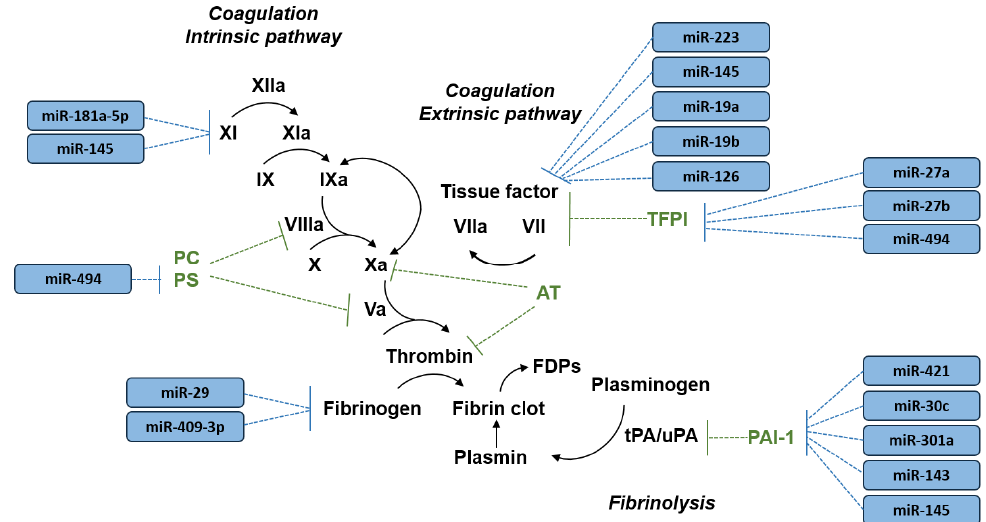
Figure 1. A simplified overview of blood coagulation and fibrinolysis pathways and the microRNAs (miRNAs) reported to regulate key hemostatic factors (see Table 1 for literature references). Black arrow indicates activation of hemostatic factors. AT, antithrombin; FDPs, fibrin degradation products; PC, protein C; PS, protein S; PAI-1, plasminogen activator inhibitor-1; TFPI, tissue factor pathway inhibitor; tPA, tissue plasminogen activator; uPA, urokinase plasminogen activator.